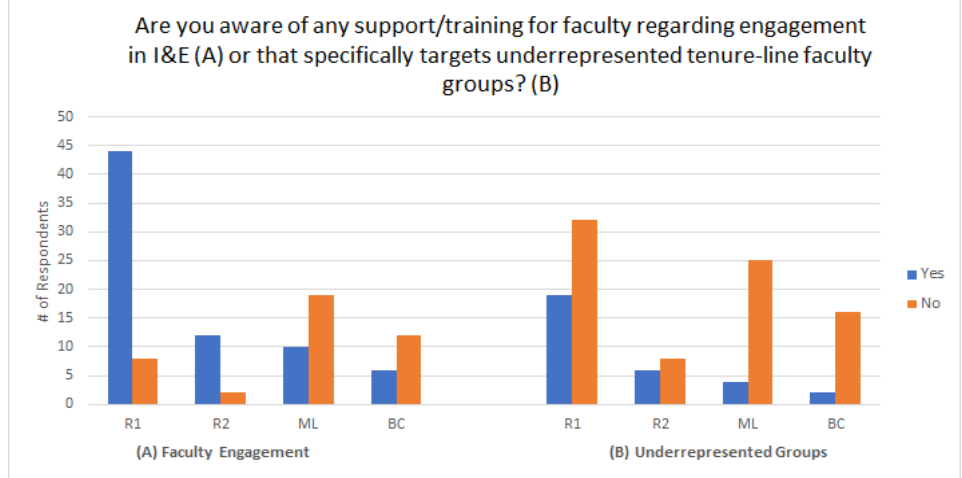
Figure 16. Comparison of institution type responses of awareness of support or training at their